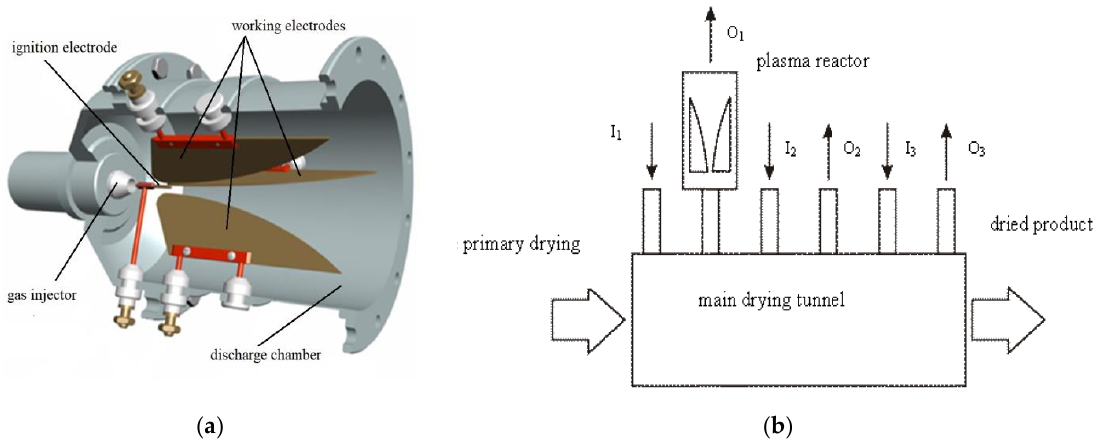
Figure 8. ( a ) GAD plasma reactor; ( b ) drying system in the paint shop, (I1, I2, I3) — hot air inlets, (O1, O2 ,O3) — polluted air